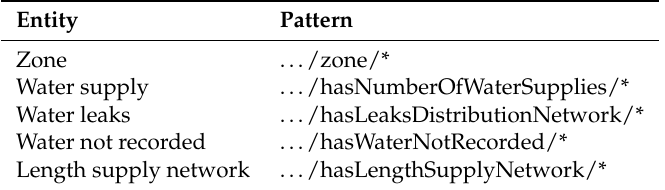
Table 4. Design patterns for the entities of the water supply company